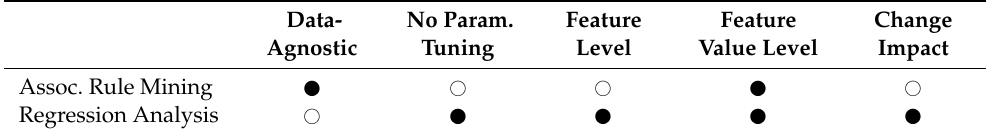
means “support” and “no support”. (cid:32) (cid:35) Data- No Param. Feature Feature Change Agnostic Tuning Level Value Level Impact